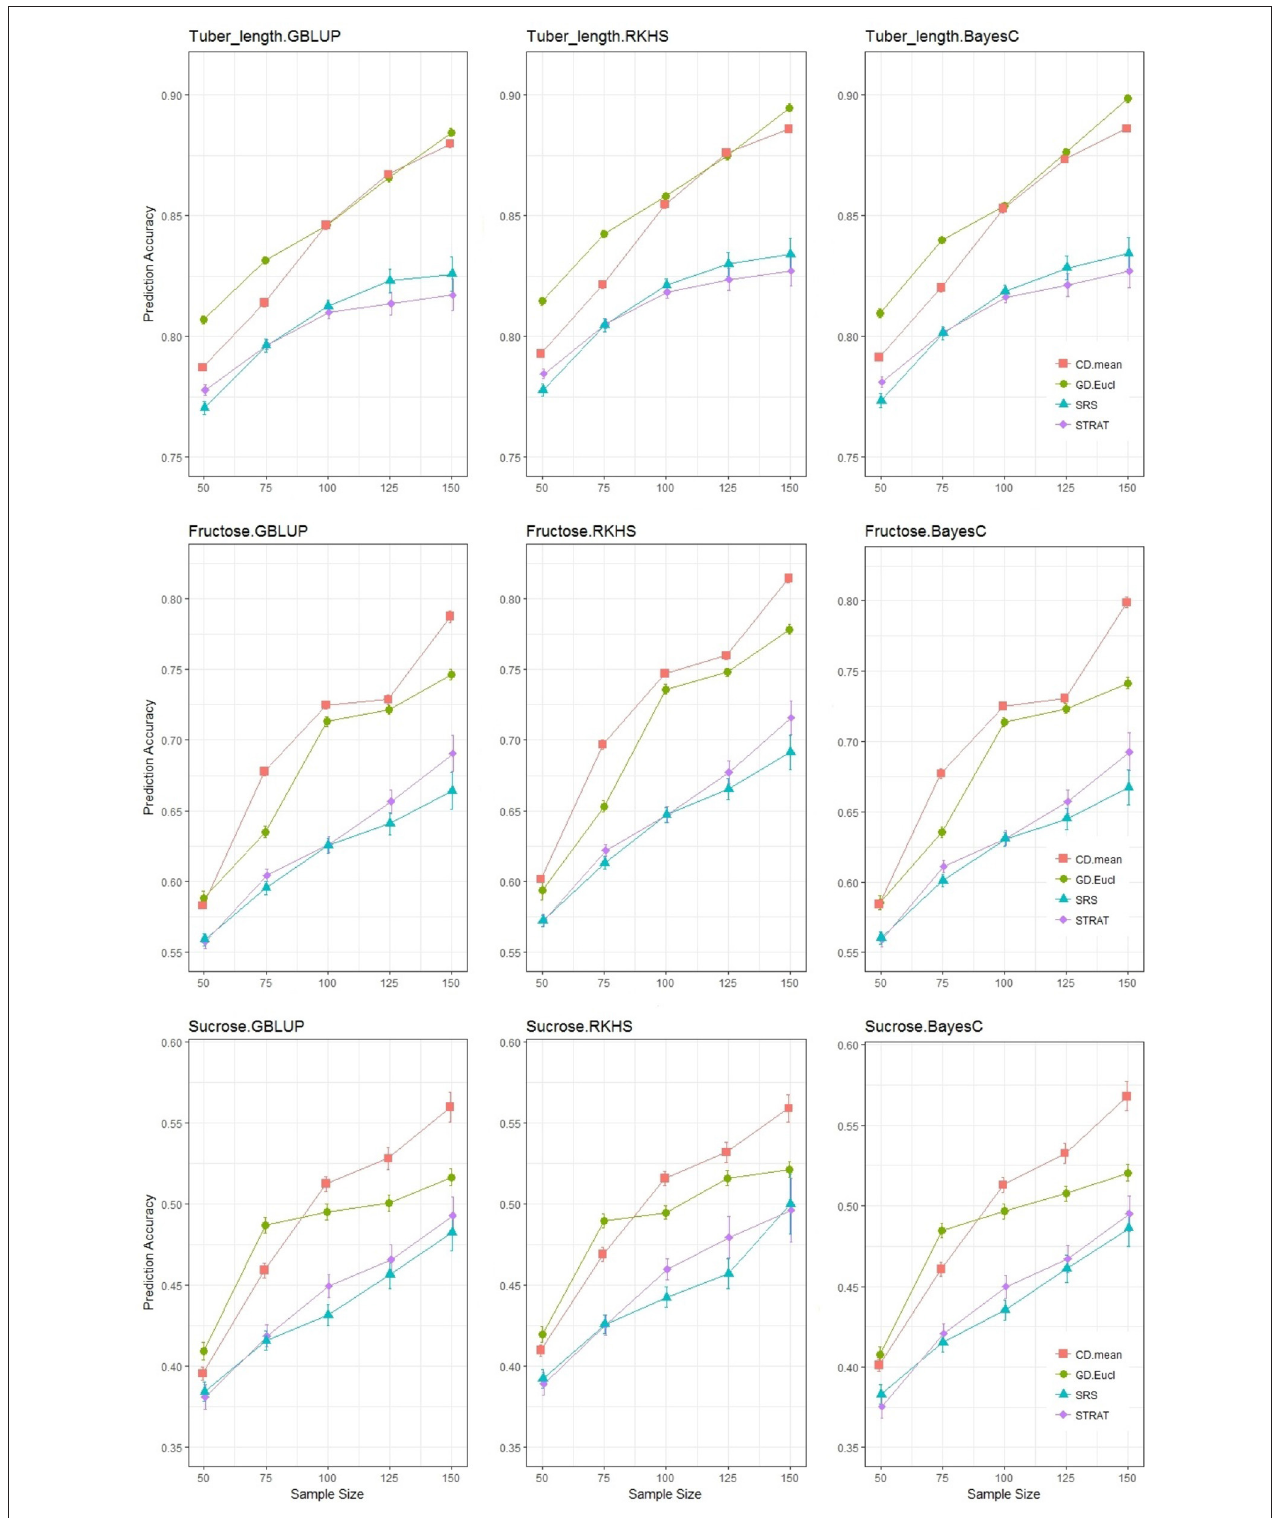
FIGURE 5 | Prediction accuracy for the 3 traits under the TV scheme (training and validation only). Each graphical window displays a different trait-statistical model combination, with varying sample sizes on the x -axis and prediction accuracy on the y -axis. The different colored lines represent different training set selection